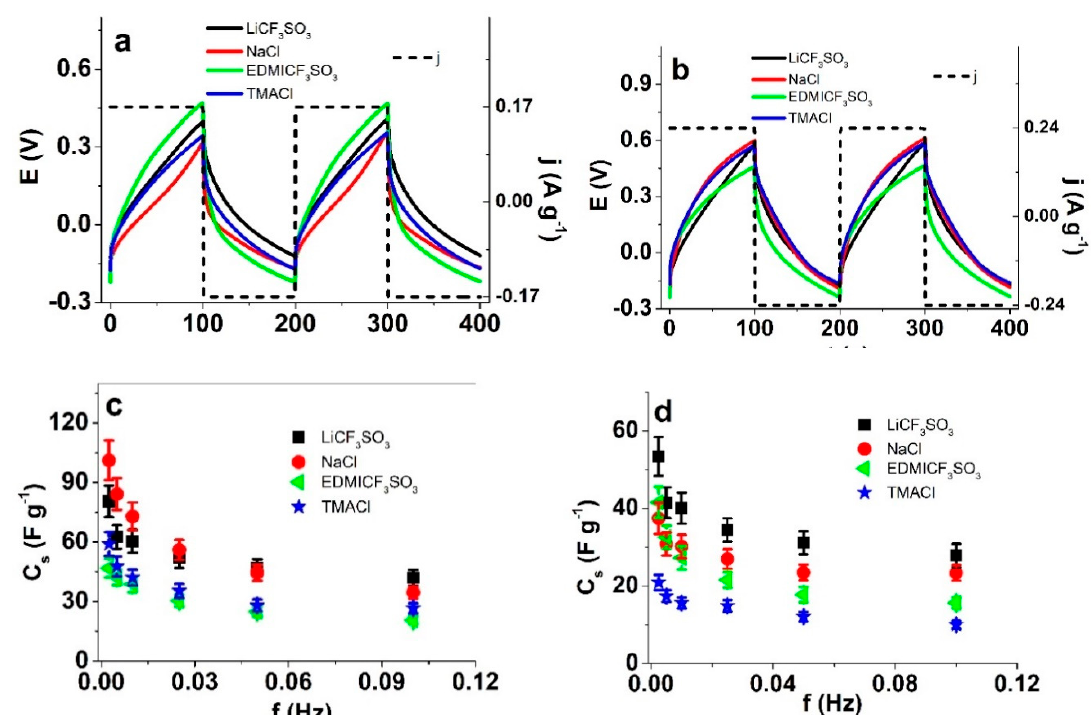
Figure 5. Chronopotentiometric responses to square current density waves for PPy-PEO/DBS (±0.085 A g − 1 , ±0.17 A g − 1 , ±0.34 A g − 1 , ±0.85 A g − 1 , ±1.7 A g − 1 and ±3.4 A g − 1 ) and PPy/DBS (±0.12 A g − 1 , ±0.24 A g − 1 , ±0.48 A g − 1 , ±1.2 A g − 1 , ±2.4 A g − 1 and ±4.8 A g − 1 ) at frequencies 0.0025 Hz, 0.005 Hz, 0.01 Hz, 0.025 Hz, 0.05 Hz and 0.1 Hz in different aqueous electrolytes (LiCF 3 SO 3 (black line), NaCl (red line), EDMICF 3 SO 3 (green line) and TMACl (blue line)) showing the potential time curves with current density j of ( a ): PPy-PEO/DBS (frequency 0.005 Hz, current density ±0.17 Ag − 1 ) and ( b ): PPy/DBS films (frequency 0.005 Hz, current density ±0.24 Ag − 1 ). The specific capacitance C s obtained from Equation (3) against the frequency in LiCF 3 SO 3 ( ■ ), NaCl ( ● ), EDMICF 3 SO 3 ( ◄ ) and TMACl ( ★ ) are shown in ( c ): for PPy-PEO/DBS and ( d ): PPy/DBS films.